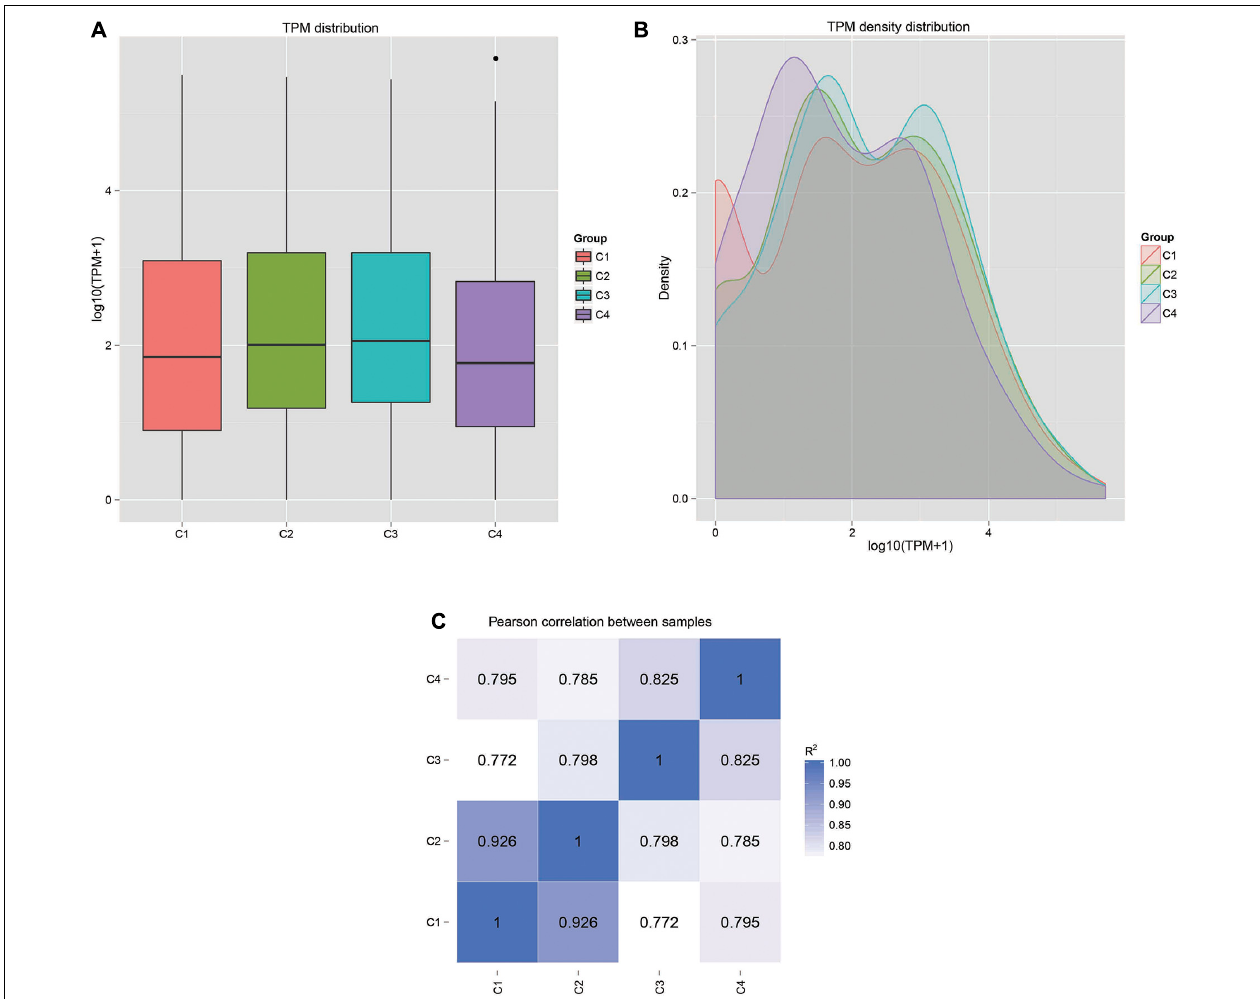
FIGURE 11 | Gene expression patterns and correlations in each sample. (A) Box plot of TPM distribution in all groups. (B) TPM density distribution diagram of miRNA expression levels. (C) Pearson correlation of miRNA expression between samples. C1: BcL.1-25 , C2: BcL.1-4 , C3: BcL.2-25 , C4: BcL.2-4